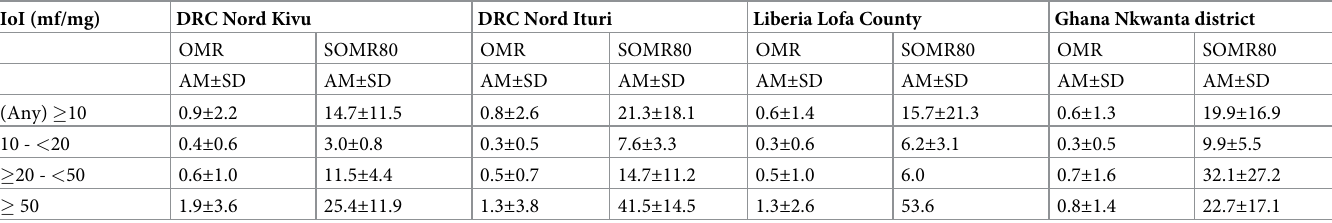
Table 5. Skin microfilariae density 1 month after ivermectin among participants without and with ‘suboptimal microfilariae response’. IoI (mf/mg)